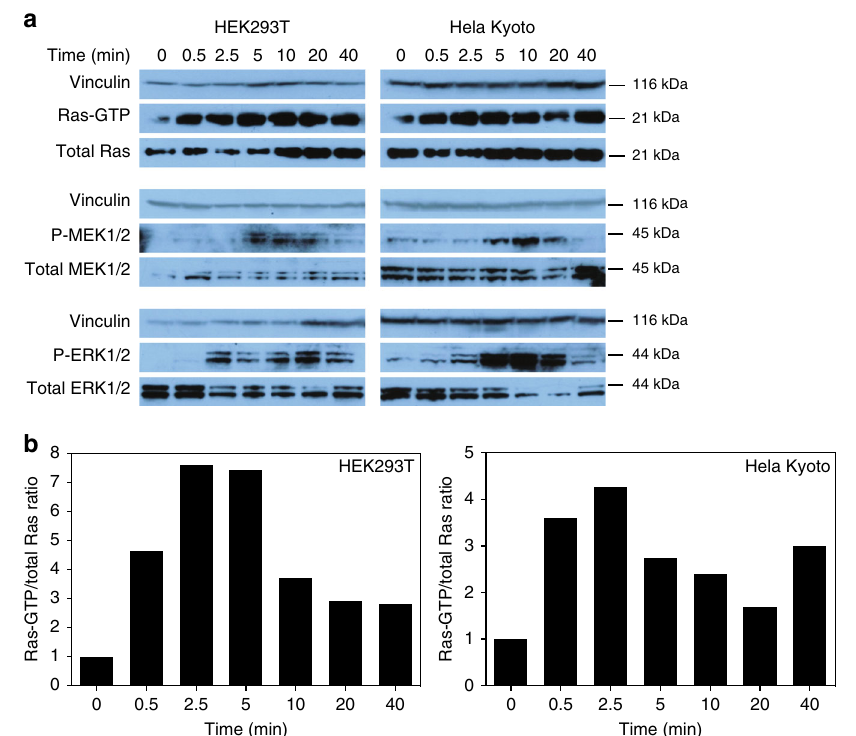
Fig. 8 Addition of glucose triggers activation of the Ras/MEK/ERK pathway in glucose-starved human HEK293T and Hela Kyoto cells. a Western blot analysis of Ras-GTP, P-MEK and P-ERK levels at different time points after glucose addition to HEK293T (left) and Hela Kyoto (right) cells. Samples at time point 0 were taken prior to glucose addition. Results are representative for at least three repetitions. b Quanti fi cation of Ras-GTP levels relative to total Ras signals, as depicted in a . All values are expressed relative to that of sample t = 0, after correction with the vinculin loading